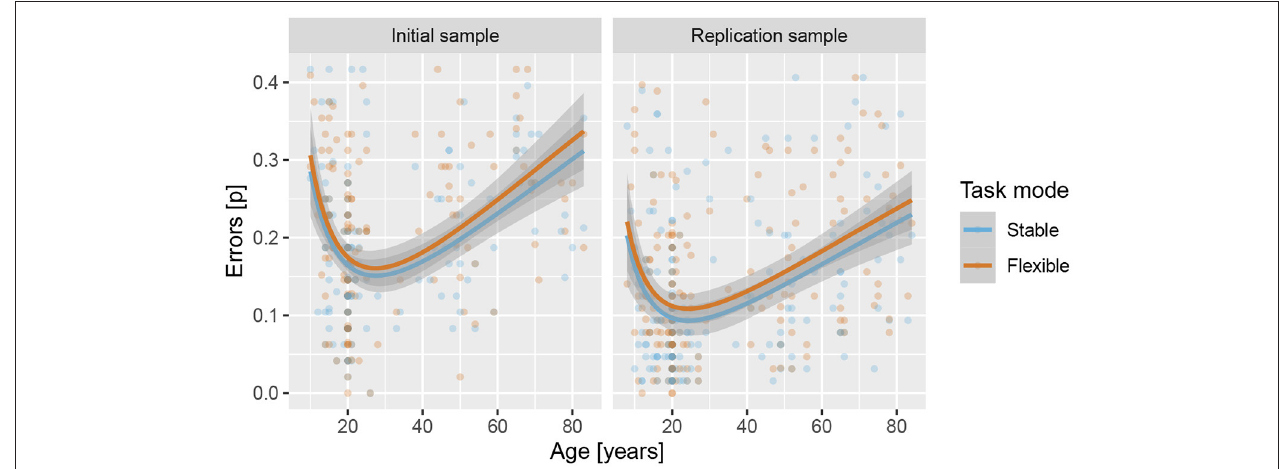
FIGURE 6 | Error rates across lifespan for the stable and flexible task modes for both samples. Lines show predicted values based on linear regression, with age modelled as a second-degree polynomial of the logarithm of age in years, and shading shows the standard error of predicted